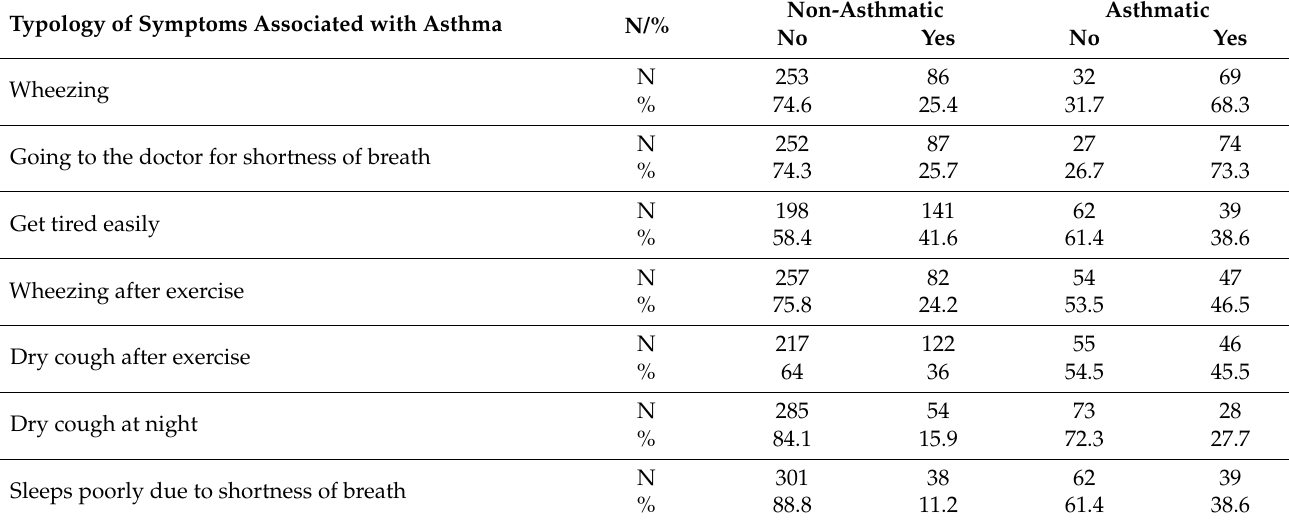
Table 4. Prevalence of symptoms associated with asthma in asthmatic and non-asthmatic